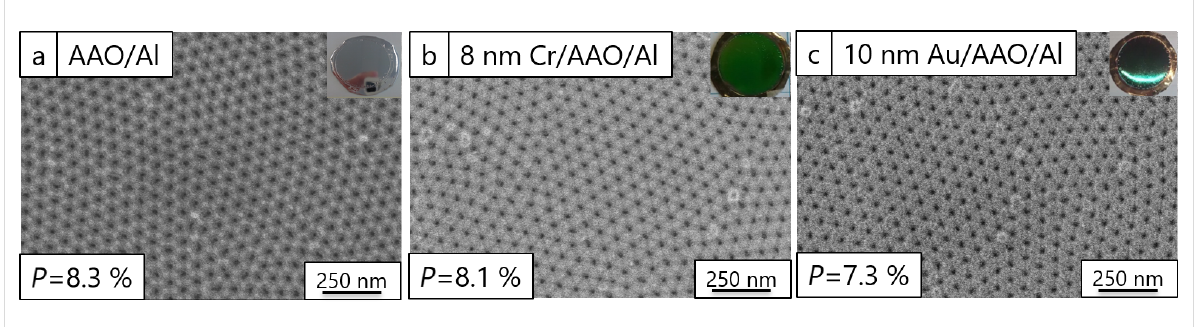
Figure 1: (a) FESEM image of an AAO–Al film, (b) FESEM image of an 8 nm Cr–AAO–Al film, and (c) FESEM image of a 10 nm Au–AAO–Al film. The insets show photos of the nanostructures.